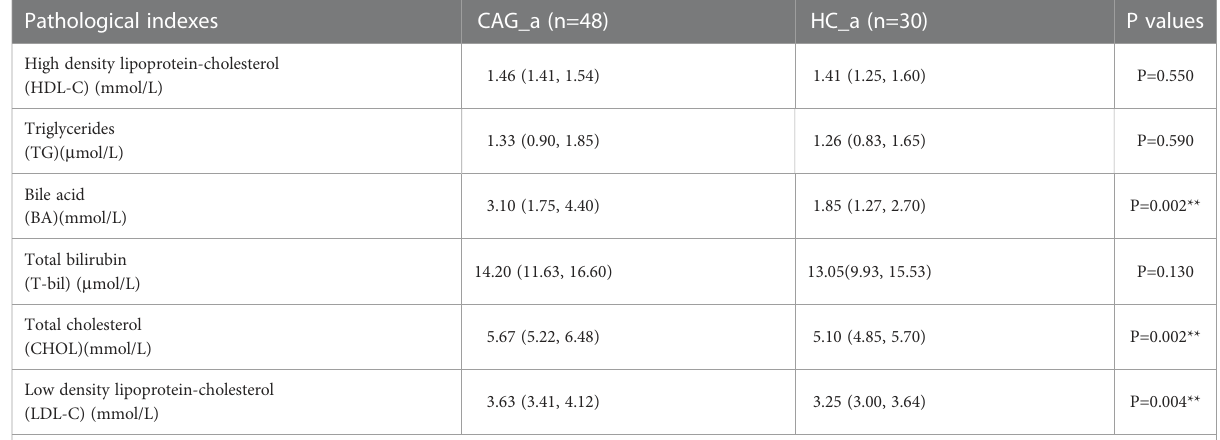
TABLE 2 Comparison of HDL-C, TG, BA, T-bil, CHOL and LDL-C between CAG_a group and HC_a group [M (Q25, Q75)]. Pathological